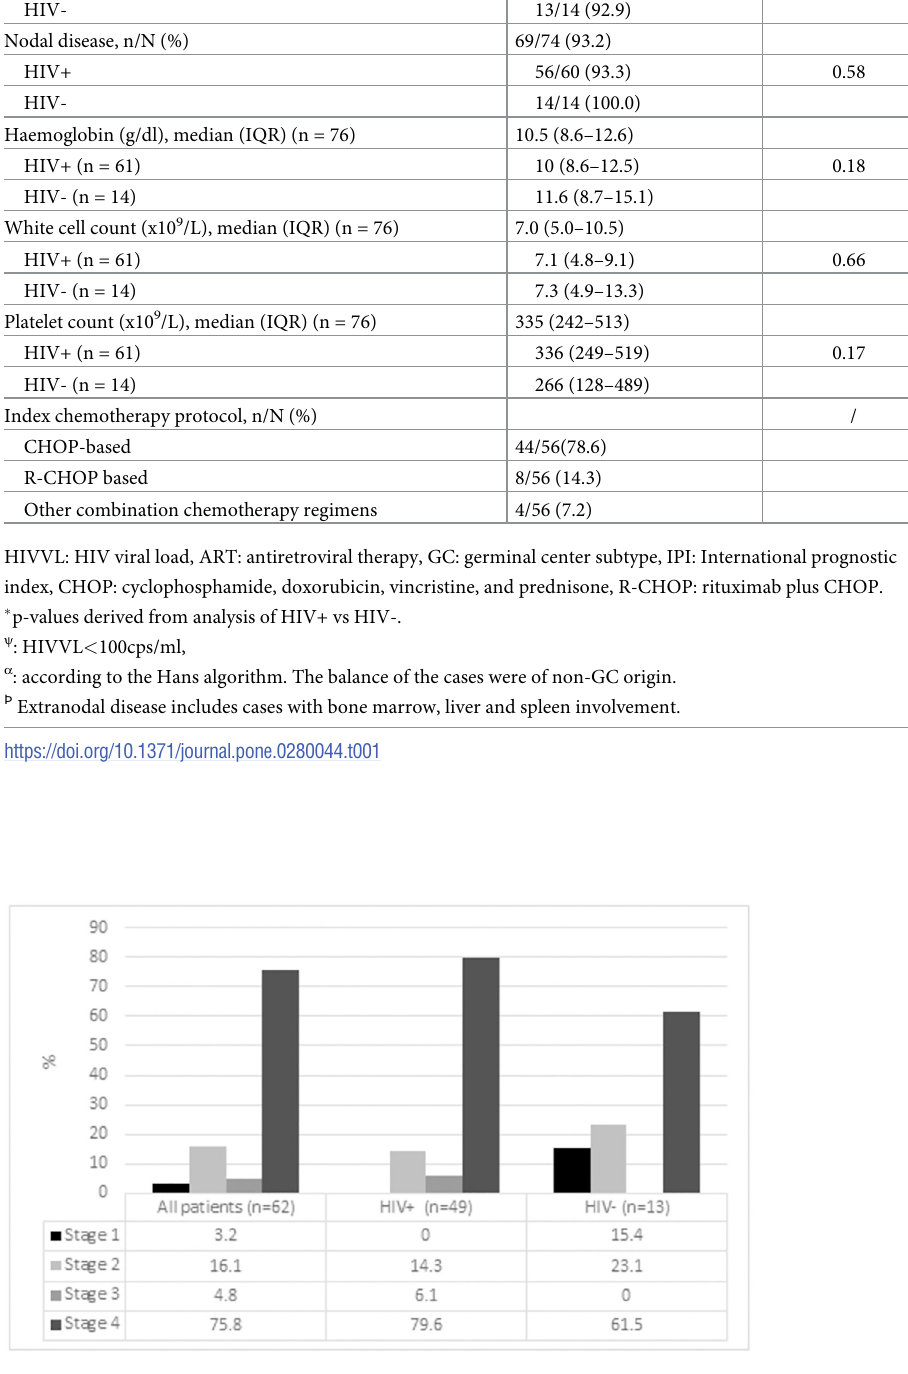
Fig 1. Distribution of disease stage according to HIV